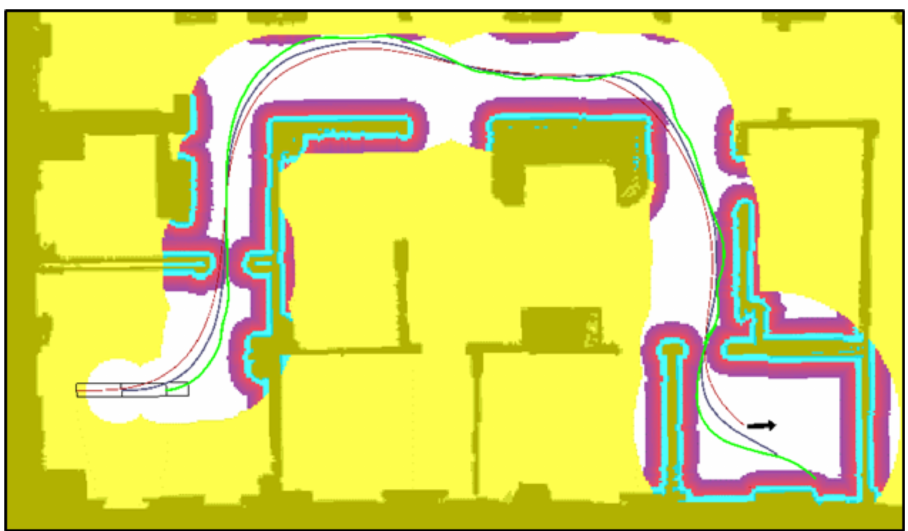
Figure 8. Trajectories followed by the tractor (green) and each of the two trailers (blue and